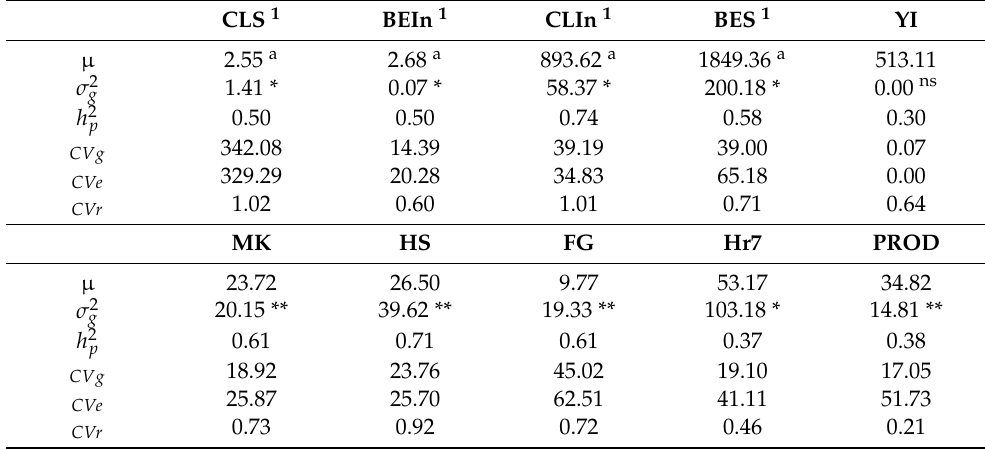
Table 1. Estimates of genetic parameters related to the incidence and severity of rust (CLI, CLS) and brown eye spot (BEI, BES), yield (YI), moka grain percentage (MK), high sieve percentage (HS), floating grain (FG) percentage, the productivity of the seventh harvest (Hr7), and the productivity of the seven consecutive harvests (PROD).